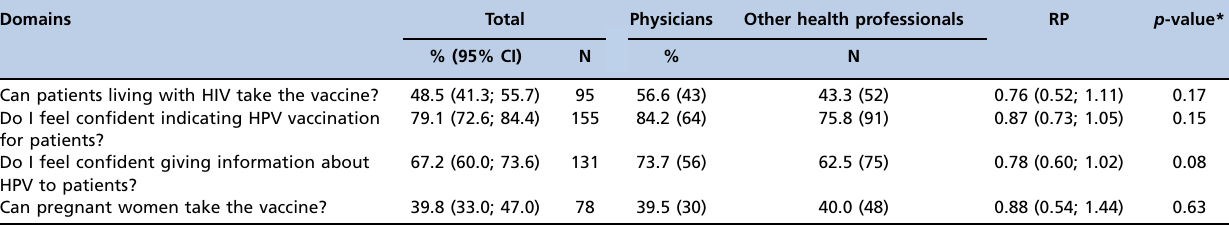
Table 4 - Clinical knowledge of the HPV vaccine among physicians and other health professionals interviewed in the Health Care System for Women and Children (SASMC) in the state of Acre, Brazil, in 2017.